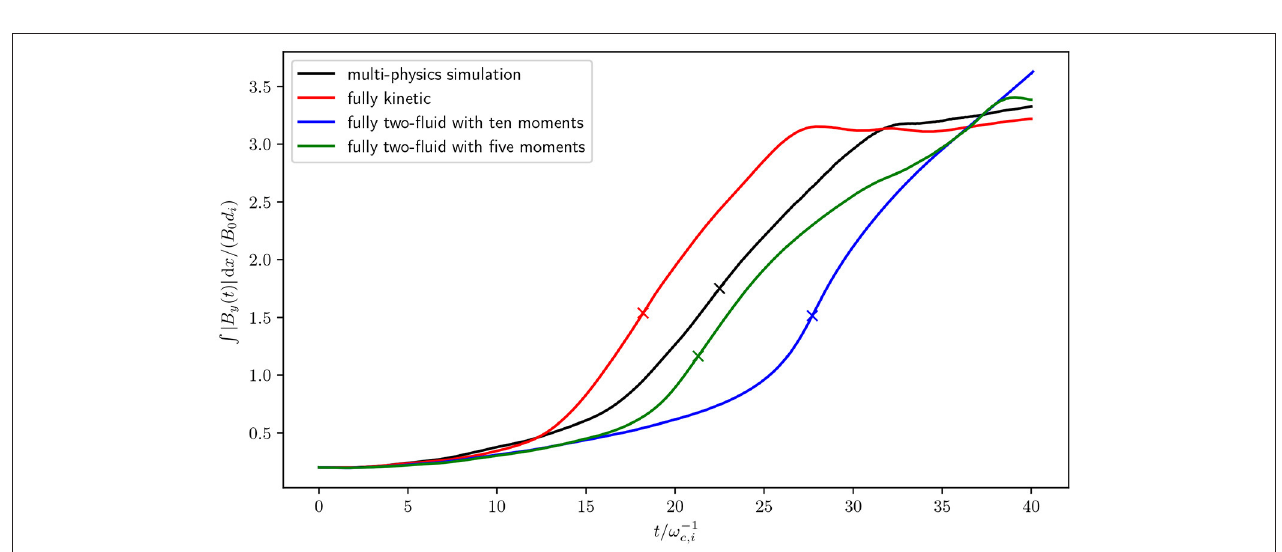
FIGURE 5 | Reconnection fluxes for the coupled run and some uncoupled comparison runs with a single solver. Crosses mark the point of highest reconnection rate throughout the respective run.